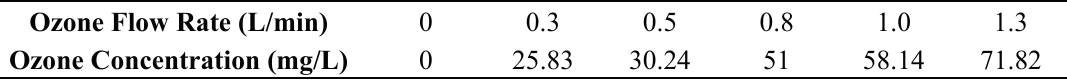
Table 2. The relationship between ozone concentration and flow rate.